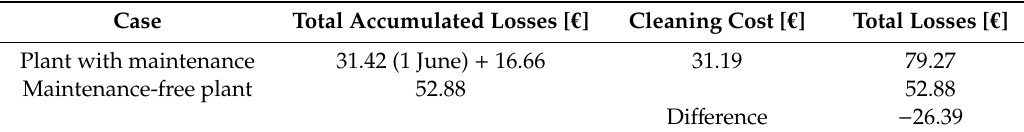
Table 6. Economic losses for the CIESOL plant (9 kWp) under the two proposed scenarios. Case Total Accumulated Losses [ € ] Cleaning Cost [ € ] Plant with